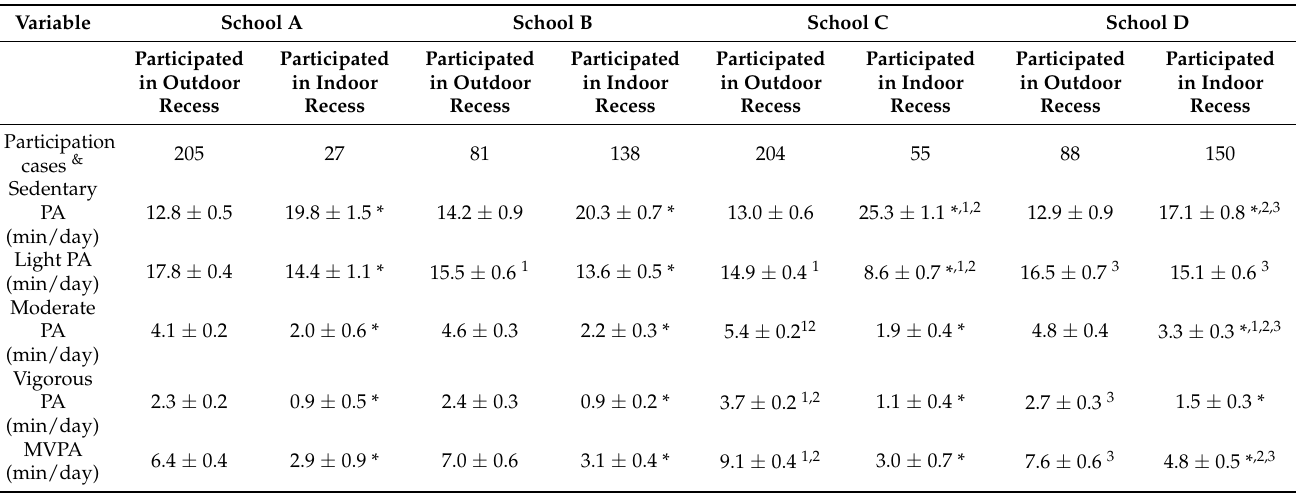
Table 5. Differences in time spent in different activity levels between the four schools (mean ± SE) during outdoor/indoor